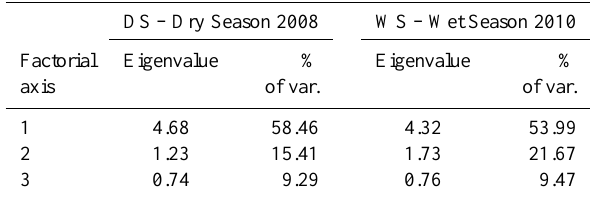
Table 4. Results of the PCA carried out on samplings DS and